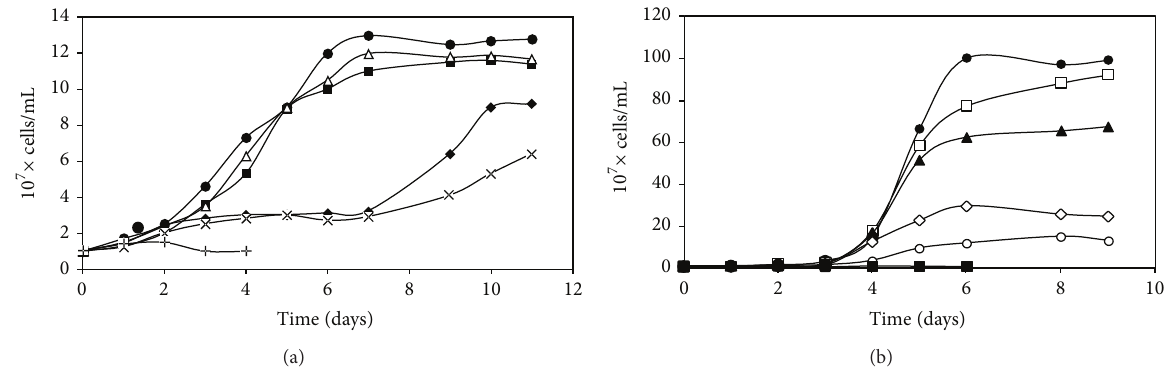
Figure 1: Growth of S. metallicus (a) and S. solfataricus (b) in the presence of Cd. Cells were inoculated in their respective growth media in absence of added Cd ( ∙ ), or were supplemented with 0.005 mM ( (cid:2) ), 0.01mM ( (cid:3) ), 0.05 mM ( ♦ ), 0.1mM ( (cid:2) ), 0.5mM ( (cid:5) ), 1mM ( △ ), 2mM ( (cid:6) ), 3mM ( × ), or 5 mM (+) Cd, and cells were counted daily.